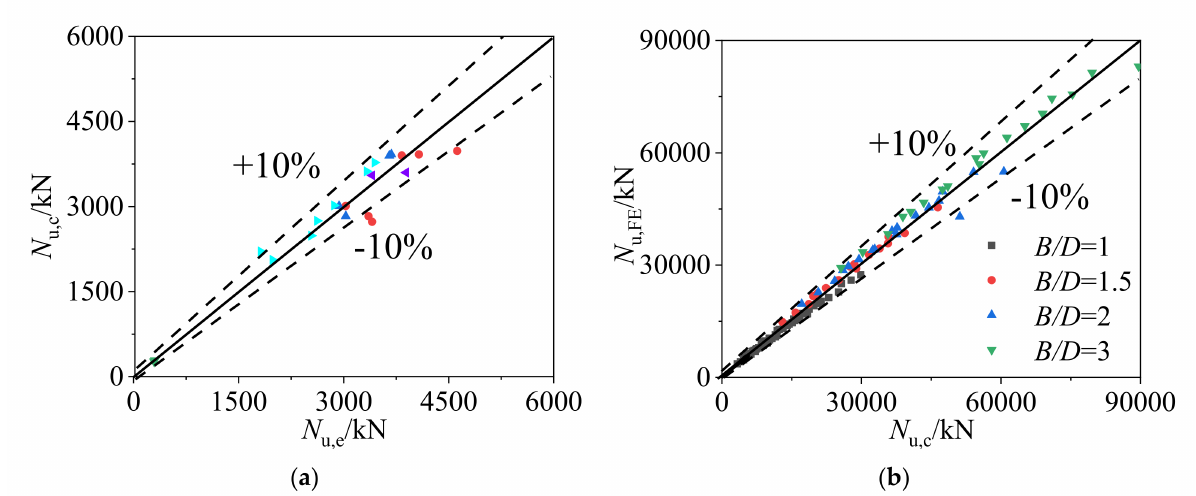
Figure 14. Comparisons from test and FE results versus Equation (13) results: ( a ) comparison of the ultimate bearing capacities obtained from test results and Equation (13) and ( b ) comparison of the ultimate bearing capacities obtained from FE results and Equation